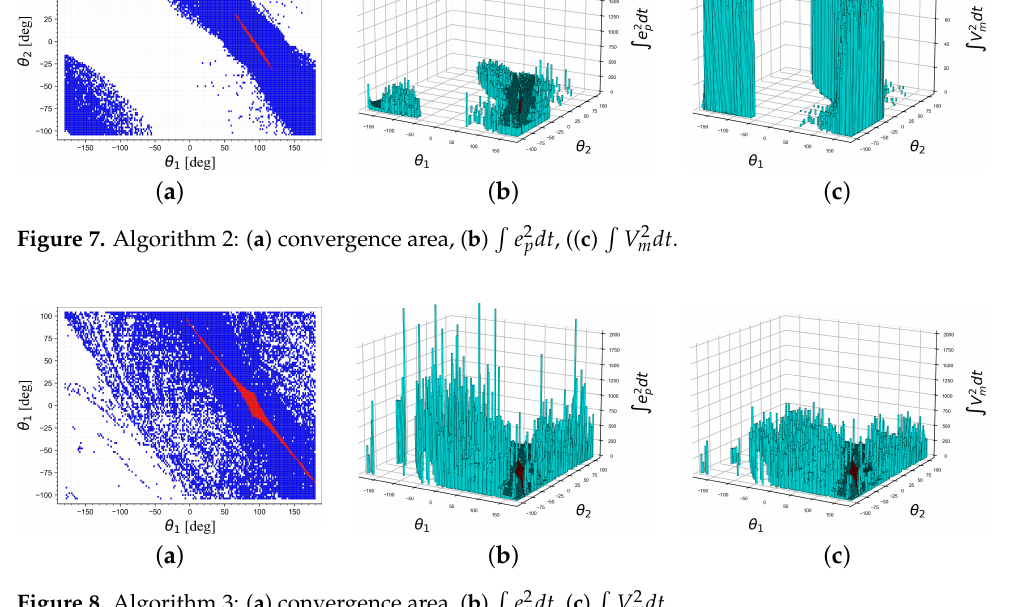
Figure 8. Algorithm 3: ( a ) convergence area, ( b )